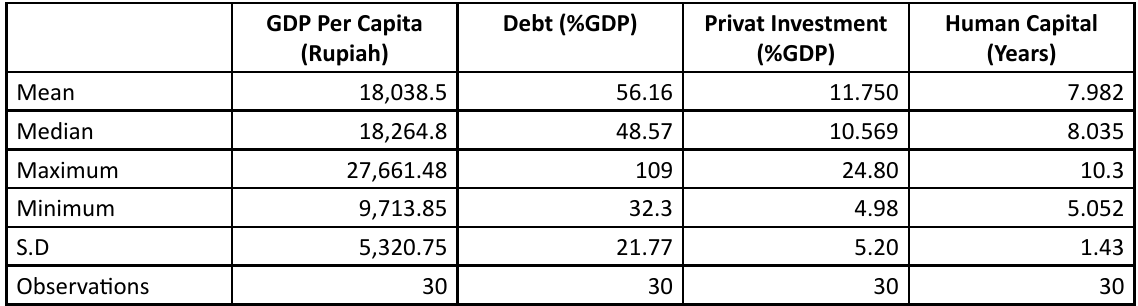
Table 2B: Descriptive Statistics - Growth Model Variables- Malaysia